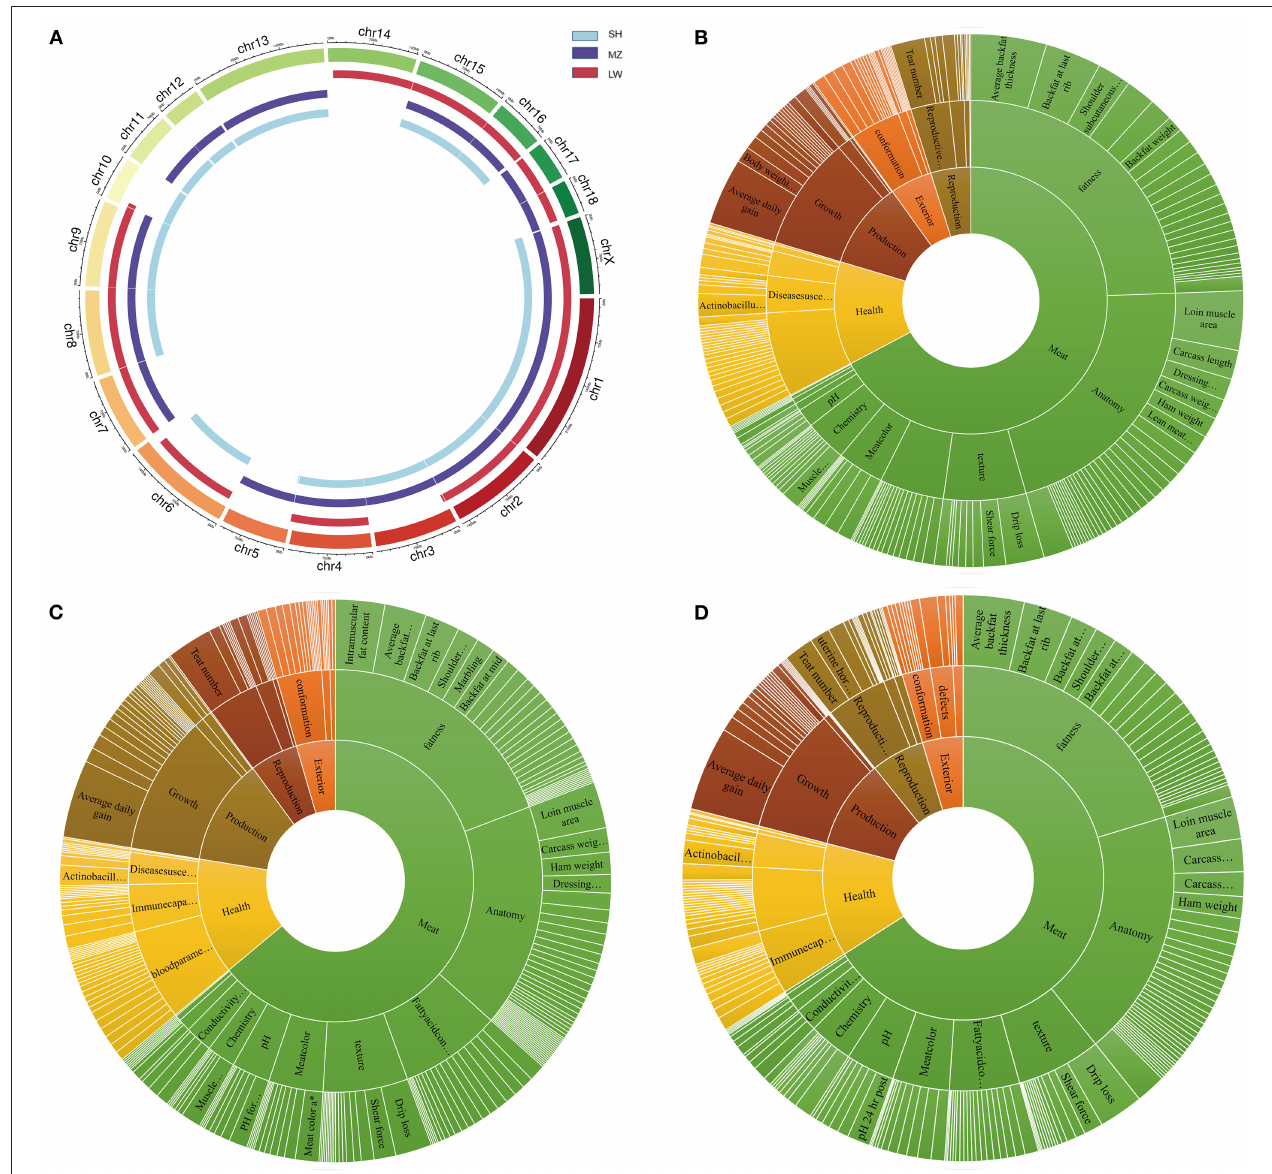
FIGURE 5 | (A) The genome distribution of the group-specific QTLs in SH, MZ, and LW pigs. (B–D) are the group-specific QTLs in SH, LW, and MZ pigs.